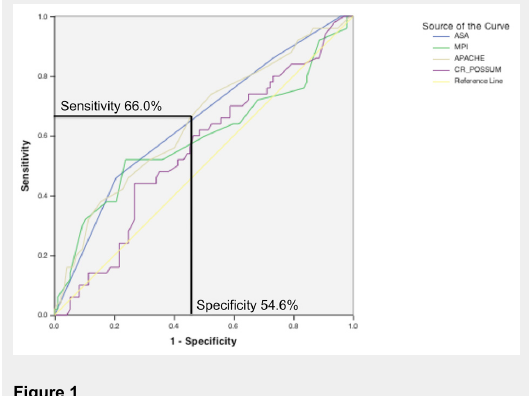
ROC curve. Sensitivity and 1-specificity for the prediction of a relaparotomy are plotted against each other for the different scores evaluated. At a cut-off score of 14 the APACHE II score shows a sensitivity and a specificity of 66.0%, and 54.6%,